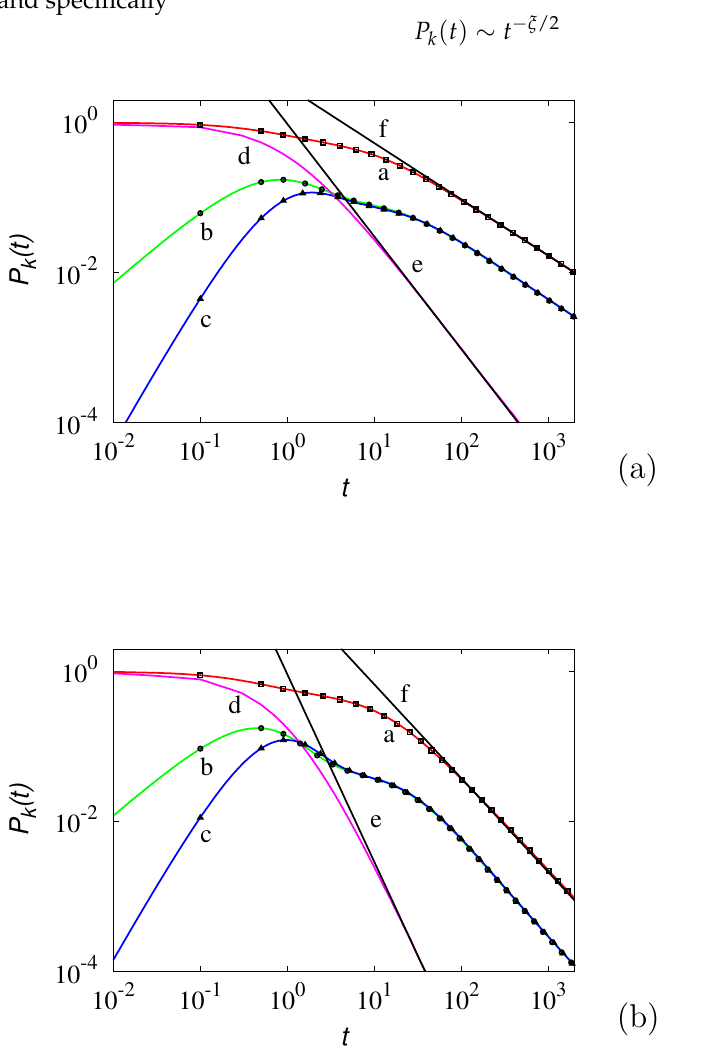
Figure 6. Counting probabilities P k ( t ) for the ES counting problem described in the main text with = 0.5. ( a ) refers to ξ = 1.5, ( b ) to ξ = 2.5. Lines are the solutions of Equation (35) µ = 0.1, π + 0 symbols the results of stochastic simulations. Lines (a) to (c) refer to k = 0,1,2, respectively. Line (d) represents the behavior of P 0 ( t ) in the absence of environmental stochasticity. Lines (e) and (f) represent the scaling P 0 ( t ) ∼ t − ξ and P 0 ( t ) ∼ t − ξ /2 ,